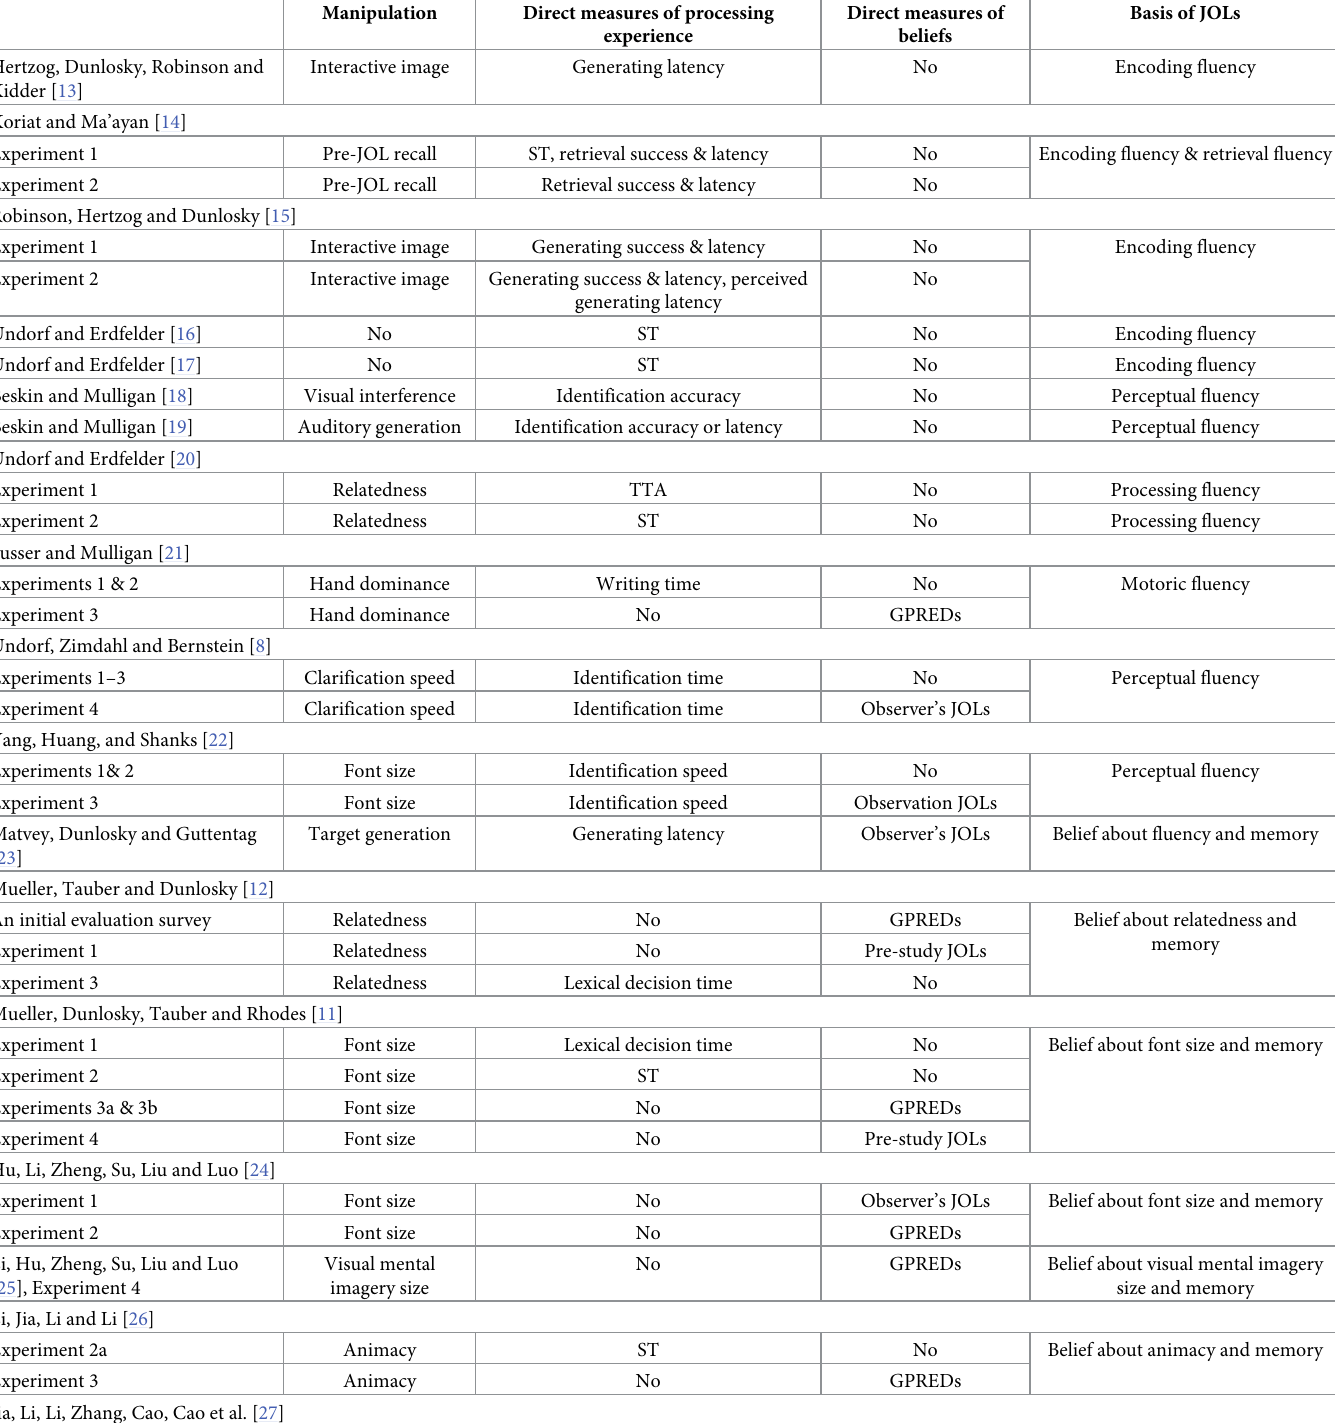
Table 1. Studies supporting processing experience and/or beliefs as the basis for JOLs. Note . ST = self-paced study time, EORs = ease of reading judgments, TTA = numbers of trials to acquisition, GPREDs = global differentiated